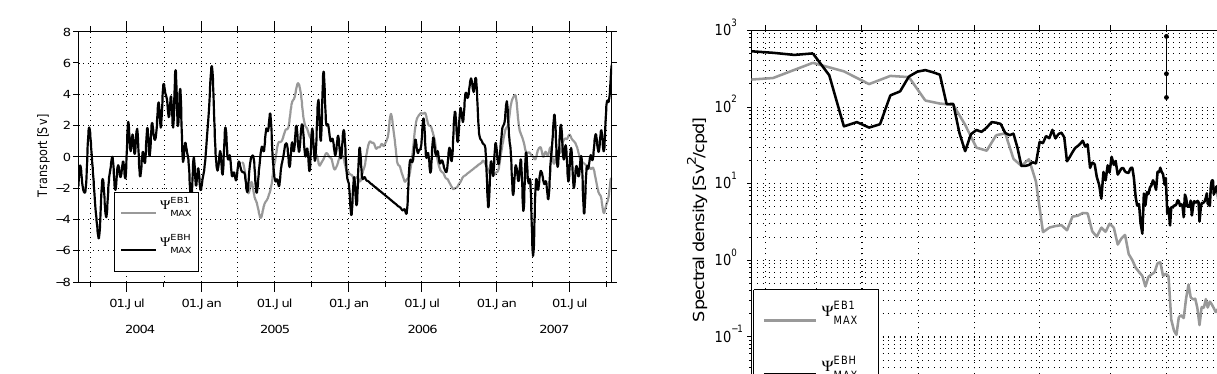
, MAX Fig. 13. Power spectra of the 10-day low-pass filtered anomalies of the eastern-boundary contribution to the AMOC at 26.5 ◦ N as derived form EB1 ( 9 EB1 , gray) and EBH ( 9 EBH , black). The MAX MAX vertical line in the upper right corner represents the 95% confidence interval. The power spectrum is computed following Percival and Walden,